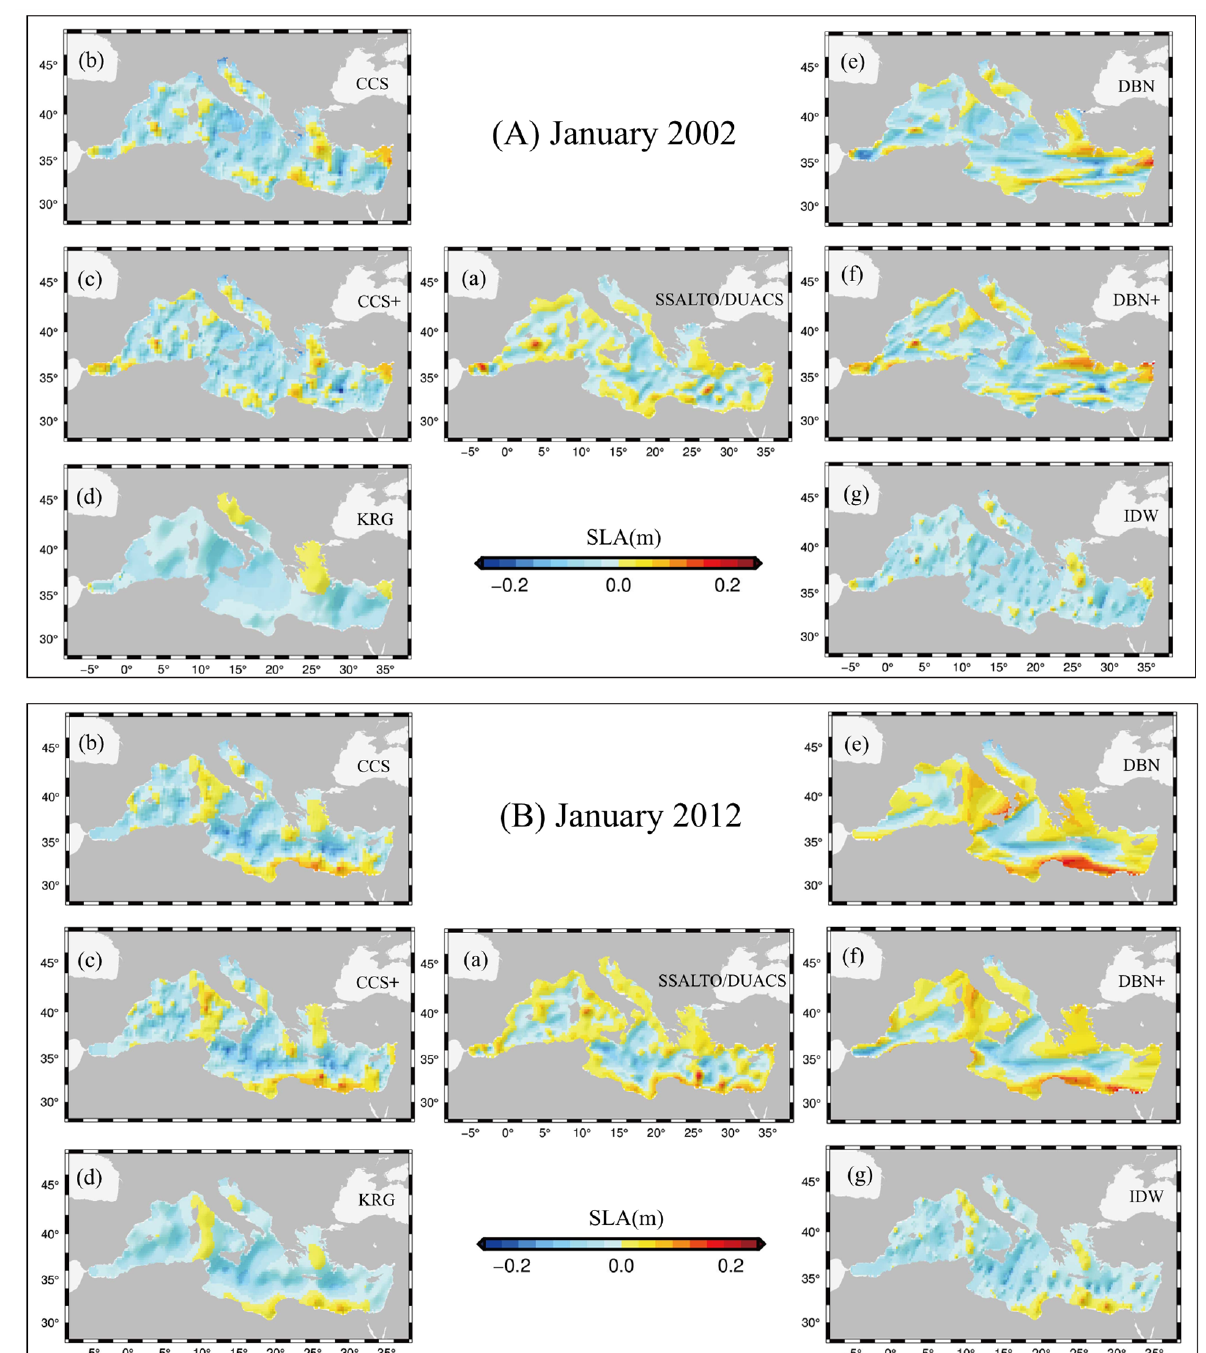
Figure 7. The spatial characteristics of the fused SLAs in January 2002 (A) and January 2012 (B) from KRG (d) , CCS (b, c) , DBN (e, f) and IDW (g) methods, as well as the product from SSALTO/DUACS (a) .